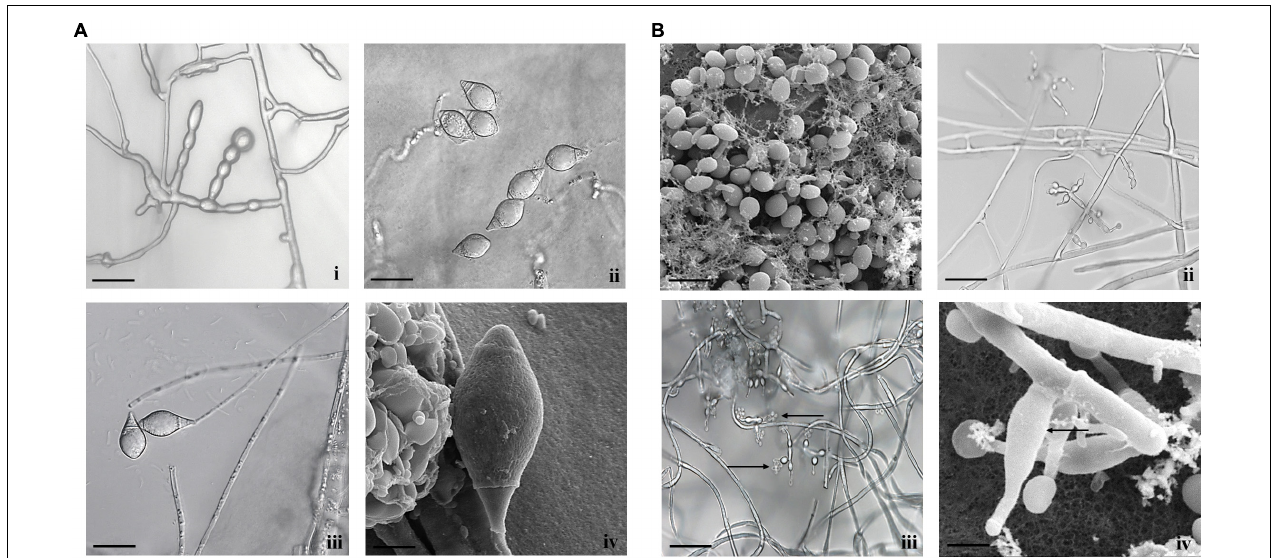
FIGURE 1 | Morphological characteristics of (A) A. thaumasia At_RK (i) chlamydospores, (ii) conidia, (iii) conidiophores with conidia (scale bar = 20 µ m), (iv) conidia observed by scanning electron microscope (SEM) (scale bar = 5 µ m), (B) T. cylindrosporum Tc_RK (i) conidia observed by SEM (scale bar = 5 µ m), (ii) conidiophores with phialides (scale bar = 20 µ m), (iii) conidiophores with phialides along with conidia (scale bar = 20 µ m), (iv) phialides under SEM (scale bar = 2 µ